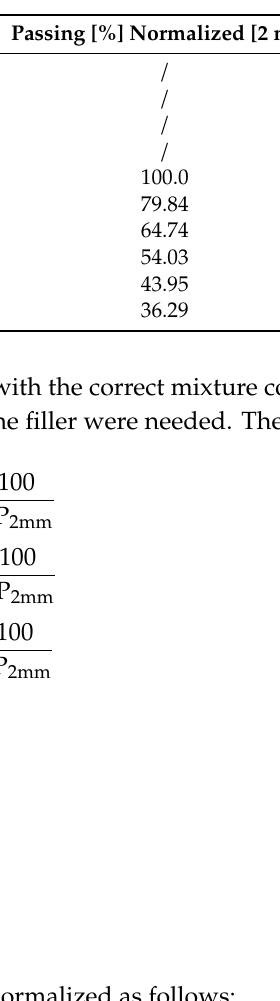
Table 2. Normalized stone mastic asphalt (SMA) grading